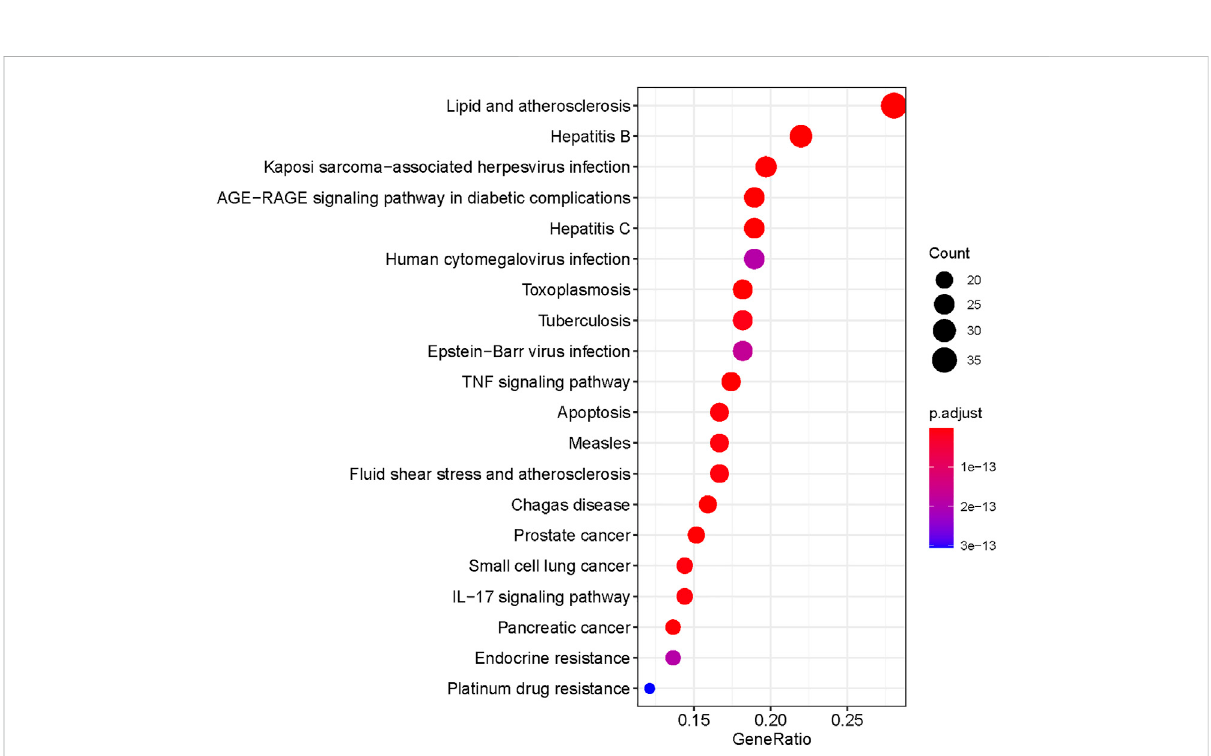
FIGURE 7 Bubble chart of the top 20 KEGG pathway enriched items.